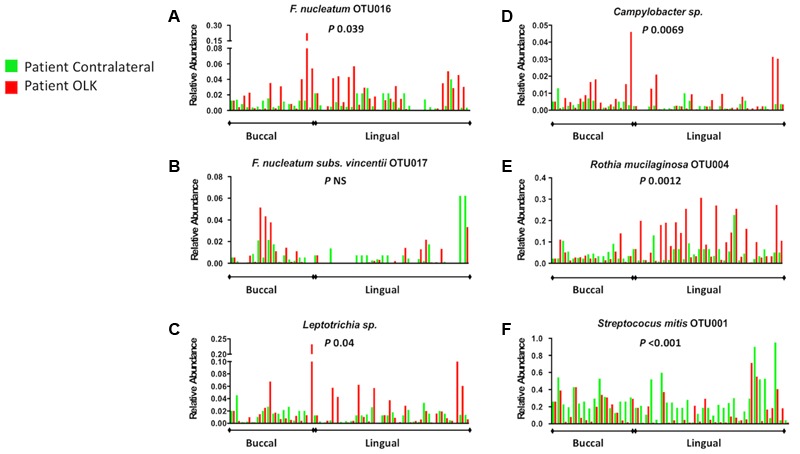
Relative abundance of selected taxonomic groups identified by LEfSe analysis. The abundance of each organism (A–F) in OLK and contralateral healthy communities from each patient is plotted side by side. No healthy tissues were available from four patients (Supplementary Table S1) and these are plotted versus the average values for control tissue. P-values refer to Wilcoxon matched pairs test results.